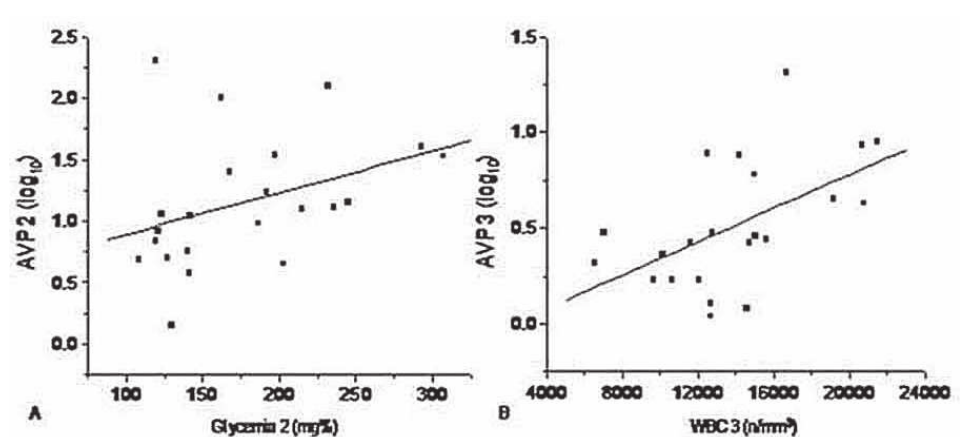
Fig. 3 – Correlation between plasmatic arginine-vasopressin, gkycemia and white blood cells. A. Correlation between plasmatic arginine-vasopressin (AVP2; pg/mL [log mg%) at T2 (6h-PO) (r = 0.45; P = 0.04). B. Correlation between plasmatic arginine-vasopressin (AVP3; pg/mL[log n/mm 3 ) at T3 (24h-PO) (r = 0.58; P =